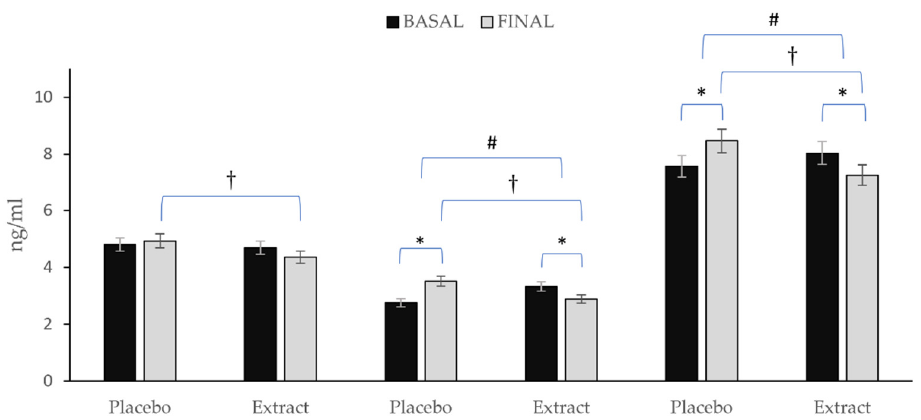
Figure 4. Variation in total prostanoids, total IsoPs, and total oxylipins in each group during the intervention. * Means significant statistical differences comparing the evolution between baseline and final intragroup ( p < 0.05). † Means significant statistical differences comparing final moment between groups at the end of the intervention ( p < 0.001). # Means significant statistical differences comparing evolution between groups during the intervention ( p < 0.05).